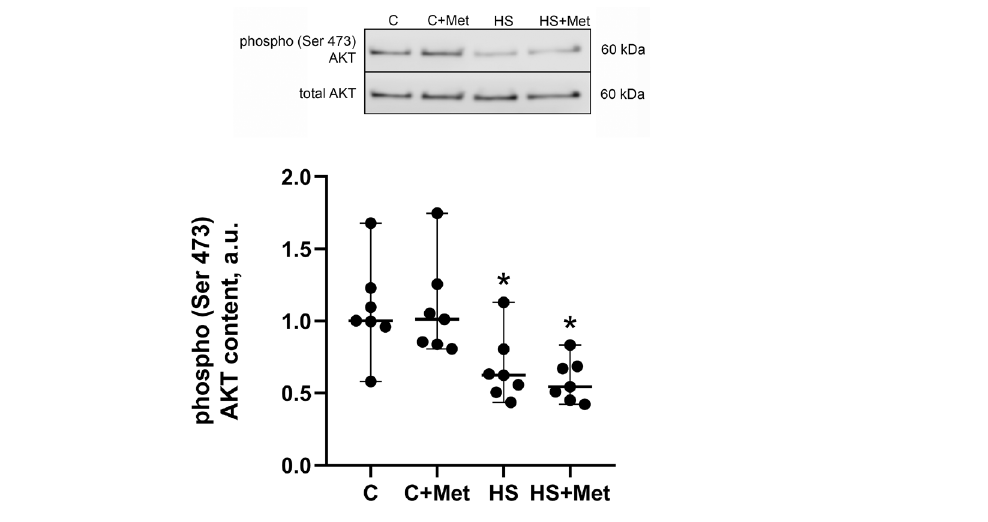
Figure 4. Effect of metformin pre-treatment on protein kinase B (AKT) (Ser473) phosphorylation in rat soleus muscle. C, vivarium control, C+Met, vivarium control + metformin pre-treatment, HS, 7-day hindlimb suspension, HS+Met, metformin pre-treatment + 7-day hindlimb suspension. Scatter dot plot indicates median values, and the whiskers represent minimum and maximum values; n = 7/group. *: p < 0.05 vs. C.